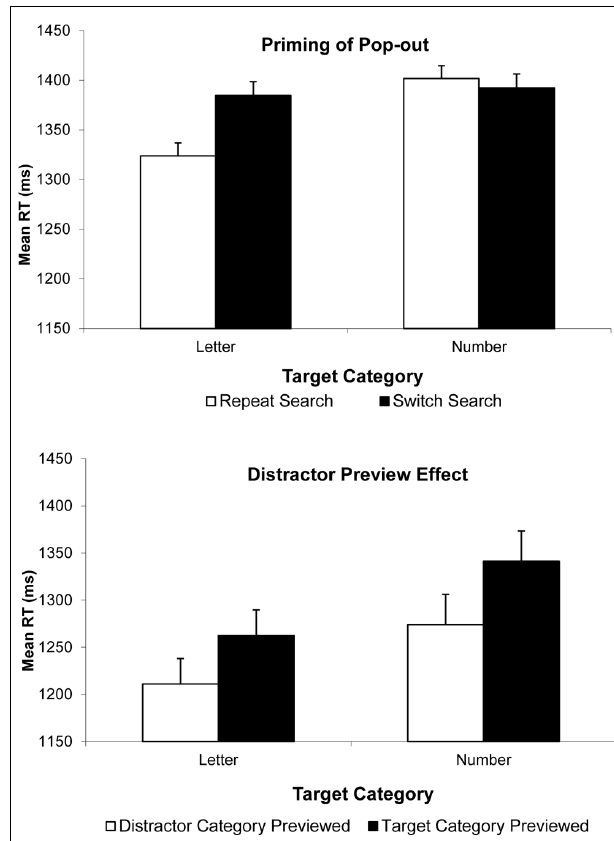
FIGURE 2 | Results of Experiments 2 (Top) and 3 (Bottom). Correct mean RTs are plotted as a function of target type (letter or number) on the current trial and trial type: Repeat Search and Switch Search conditions, for PoP in Experiment 2; and Distractor-Category Previewed and Target-Category Previewed conditions, for DPE in Experiment 3. Error bars indicate the standard error of the mean.